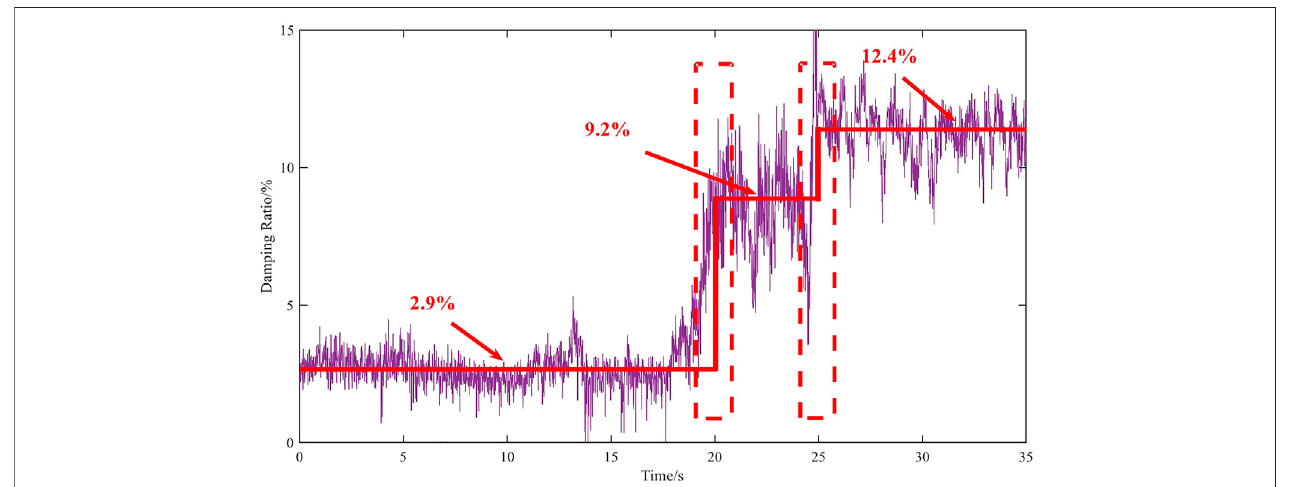
FIGURE 8 | Identi fi cation results of the interval oscillation damping ratio under the abrupt operation mode.